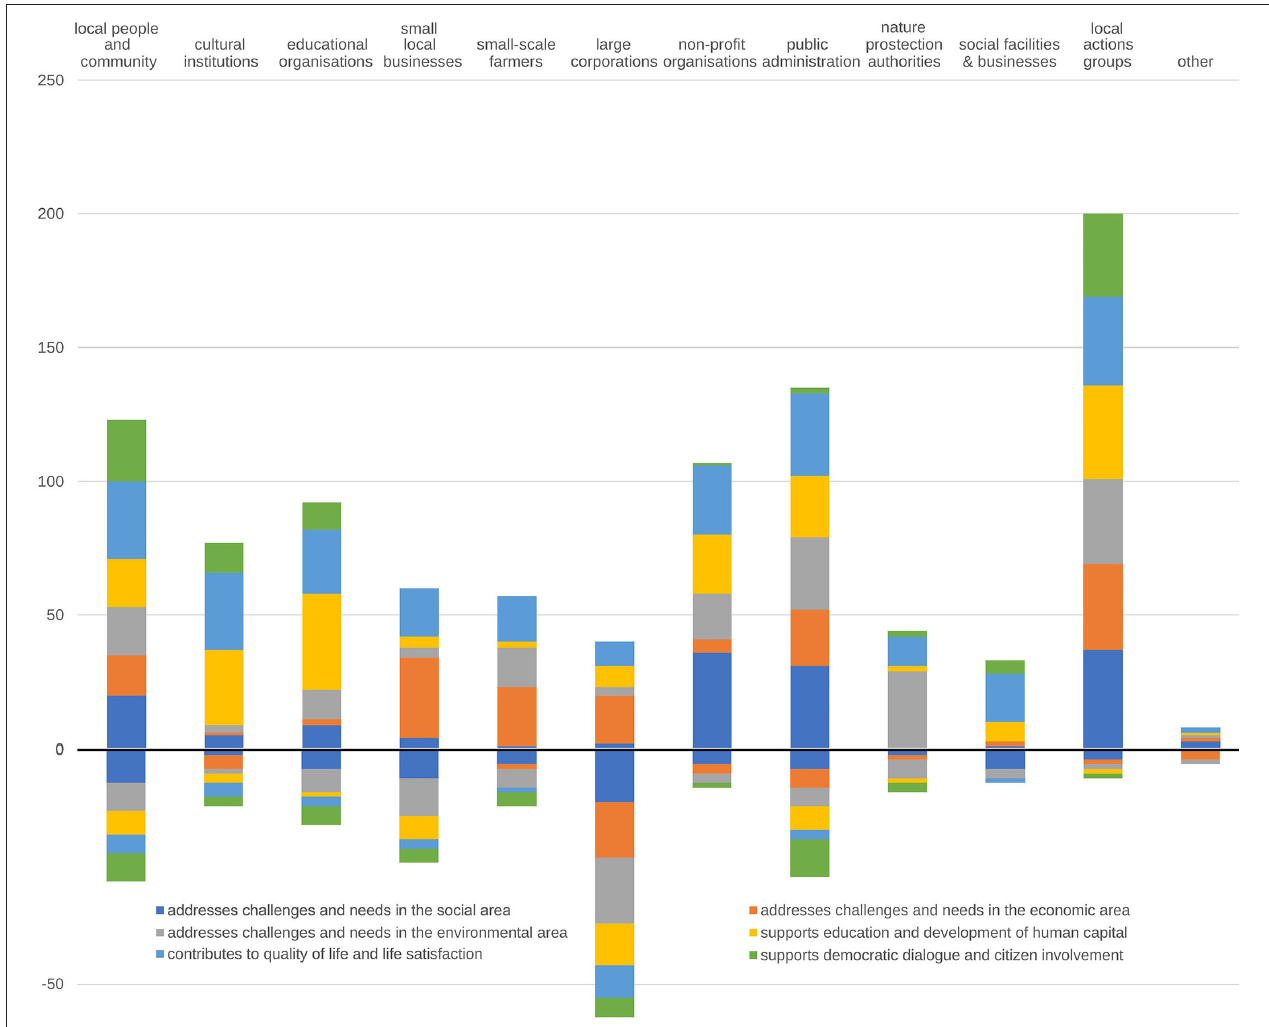
FIGURE 6 | The extent to which LAG representatives consider that selected actors are currently involved in addressing challenges and needs in the areas of sustainable development (in positive values)—compared to the extent to which LAG representatives consider that the same actors are NOT—but should be—currently involved in addressing the same challenges (in negative values). Here the answers to the two related multiple-choice questions were compared: Who IS CURRENTLY involved in your region in the following.. . and the next: Who is NOT—BUT SHOULD BE—involved in your region in the following... These questions were answered by ticking a box within the matrix—relevant for the actor and the category of